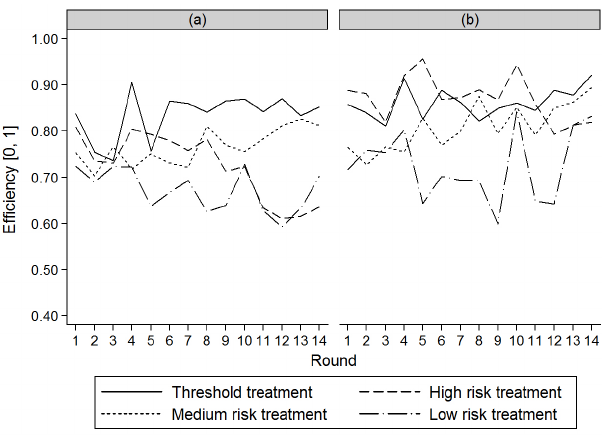
Fig. 4 . Comparison of average efficiency achieved given the current resource stock size over time between all four treatments for all groups (a) (N = 20 for threshold treatment; N = 21 for high-risk treatment; N = 23 for medium-risk treatment; N = 20 for low-risk treatment) and for cooperative groups only (b) (N = 16 for threshold treatment; N = 9 for high-risk treatment; N = 17 for medium-risk treatment; N = 9 for low-risk